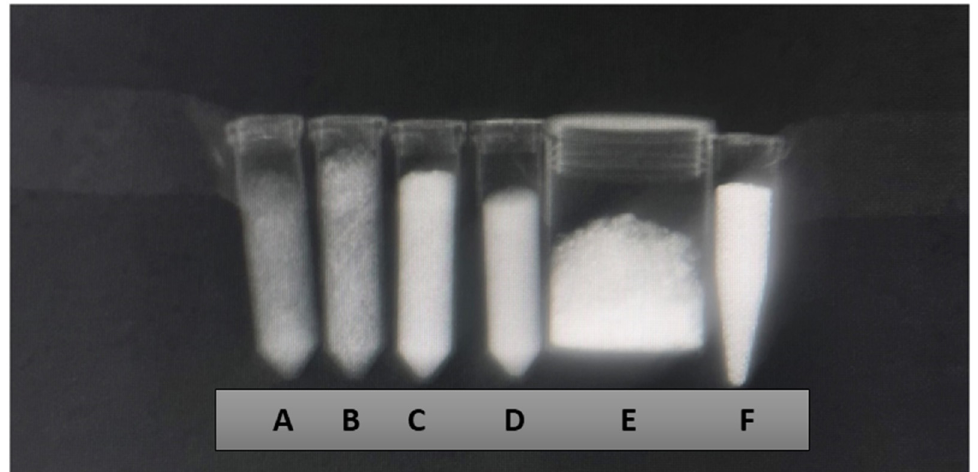
Figure 1. X-ray imaging using the wrist technique (mAs 20, ms 71, and 46 Kv) of the samples Zn-HA 10% (A), Sr-HA 10% (B), HA 01.256 CTT 1000 °C (C), HA microspheres (D), AuNP (E), and Cu-GO (F).